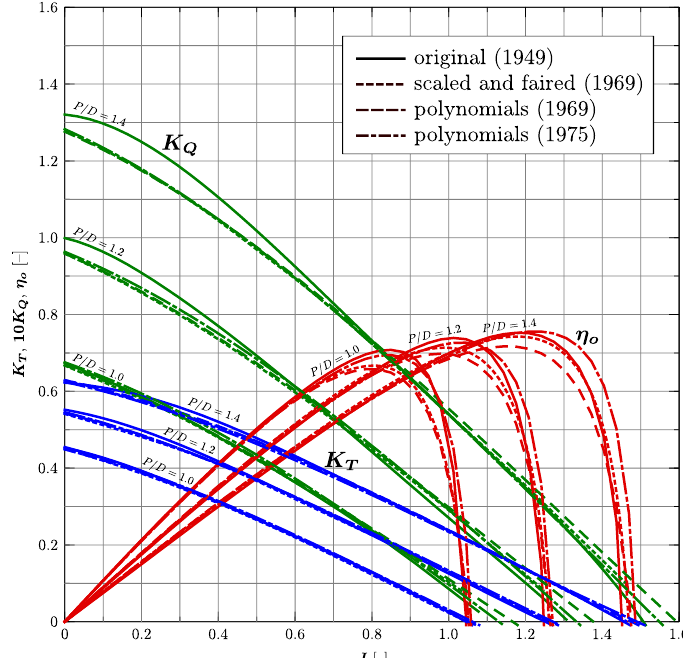
Figure 1. Open-water diagrams originally published by van Lammeren and van Aken in 1949 [4], scaled and faired, the fitted polynomials (both by van Lammeren et al. in 1969 [5]), and the most recent polynomials by Oosterveld and van Oossanen (1975) [2]) of propeller B4-70. The Reynolds number is 2.72 · 10 5 for the original data, otherwise 2 · 10 6 . Reproduced from [3] with permission from AMT’17,